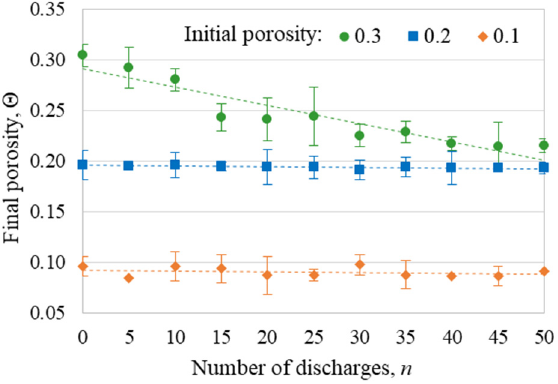
Figure 3. Final porosity of the compacts ( Θ ) versus the number of discharges, as measured by the Archimedes’ method.